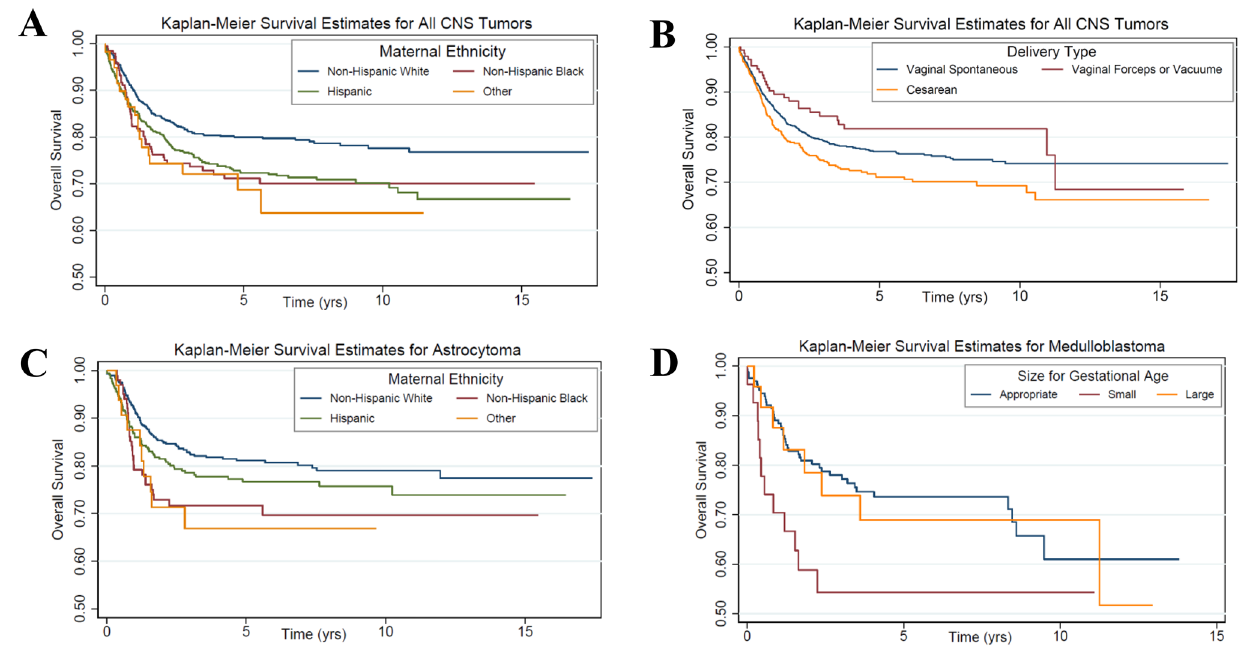
Figure 1. Kaplan–Meier estimates for overall survival in cases with pediatric central nervous system tumors according to maternal and perinatal factors. Overall survival based on Kaplan–Meier estimates for ( A ) all CNC tumor cases and maternal ethnicity ( P = 0.002); ( B ) all CNC tumor cases and delivery type ( P = 0.012); ( C ) astrocytoma cases and maternal ethnicity ( P = 0.033); ( D ) medulloblastoma cases and size for gestational age ( P =